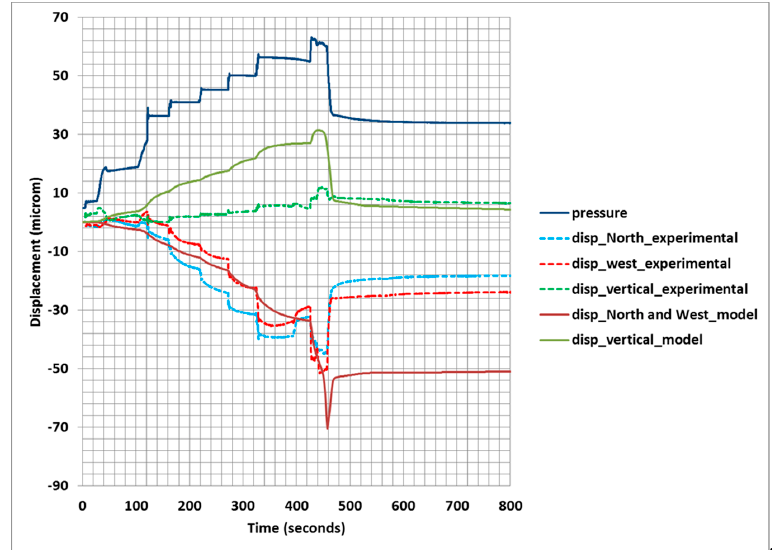
Figure 4. Comparison of calculated and measured fault displacement at injection point. Fault movement is clearly shown to be correlated to the injection pressure, but not in a proportional manner.